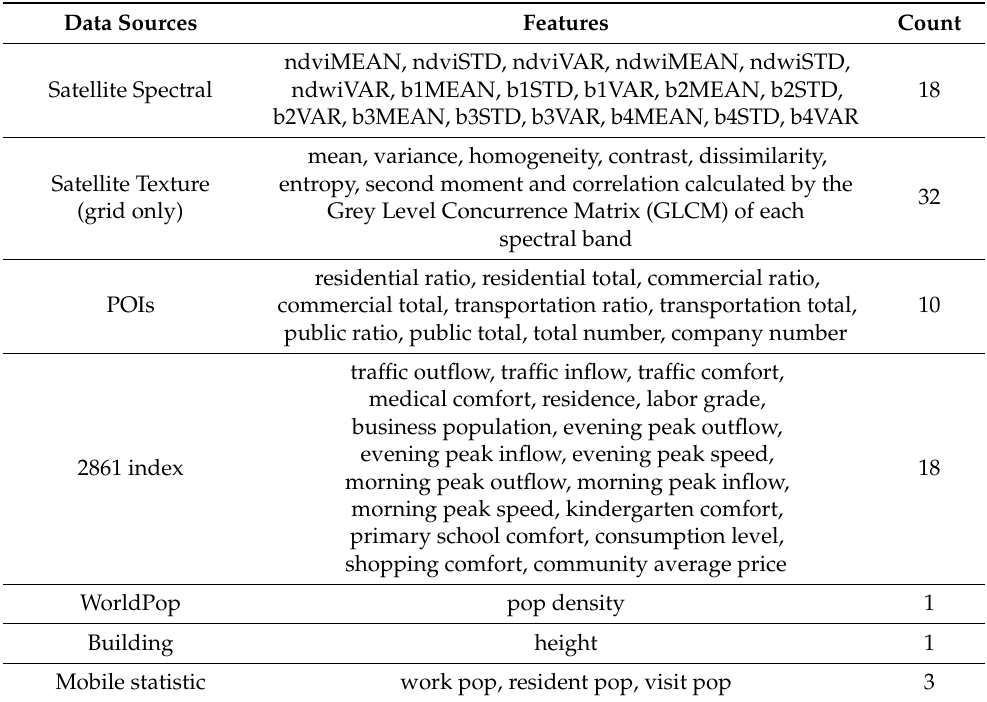
Table 2. Summary of features from CMU